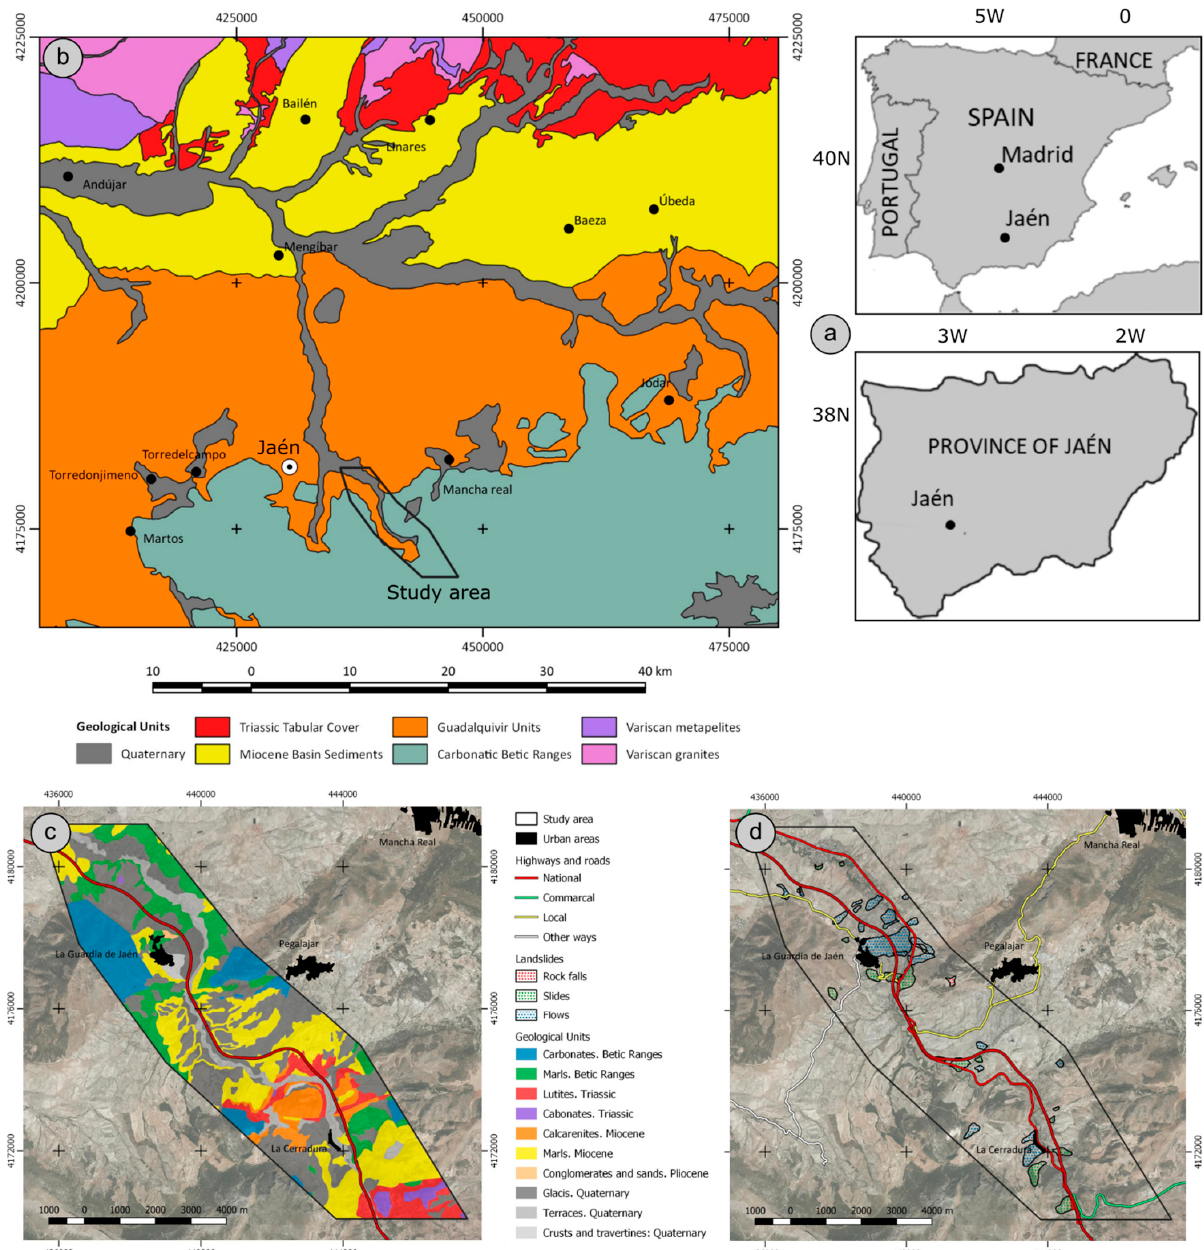
Figure 1. Geographical location and geological setting of the study area: ( a ) geographical location; ( b ) geological setting; ( c ) geological units in the study area; ( d ) landslide inventory. Coordinates are in ETRS89 ‐ UTM30.